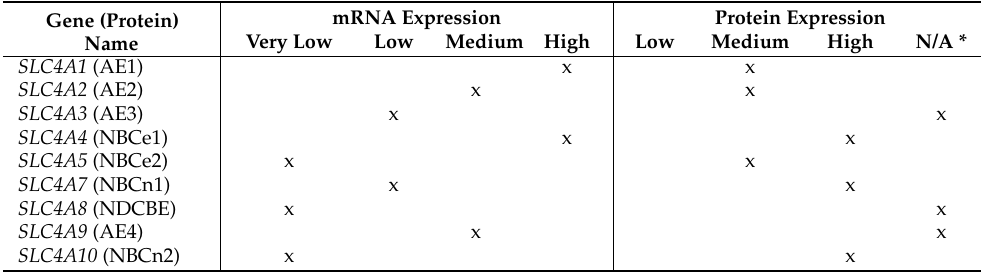
Table 1. Classification of human SLC4 family members that carry “HCO 3 − ” in the kidney. mRNA and protein expression levels were classified based on the study [96]. Very low: ≤ 5 nTPM; low: 5 ≤ 15 nTPM; medium: 15 ≤ 50 nTPM; high: >50 nTPM. * N/A means either not tested or